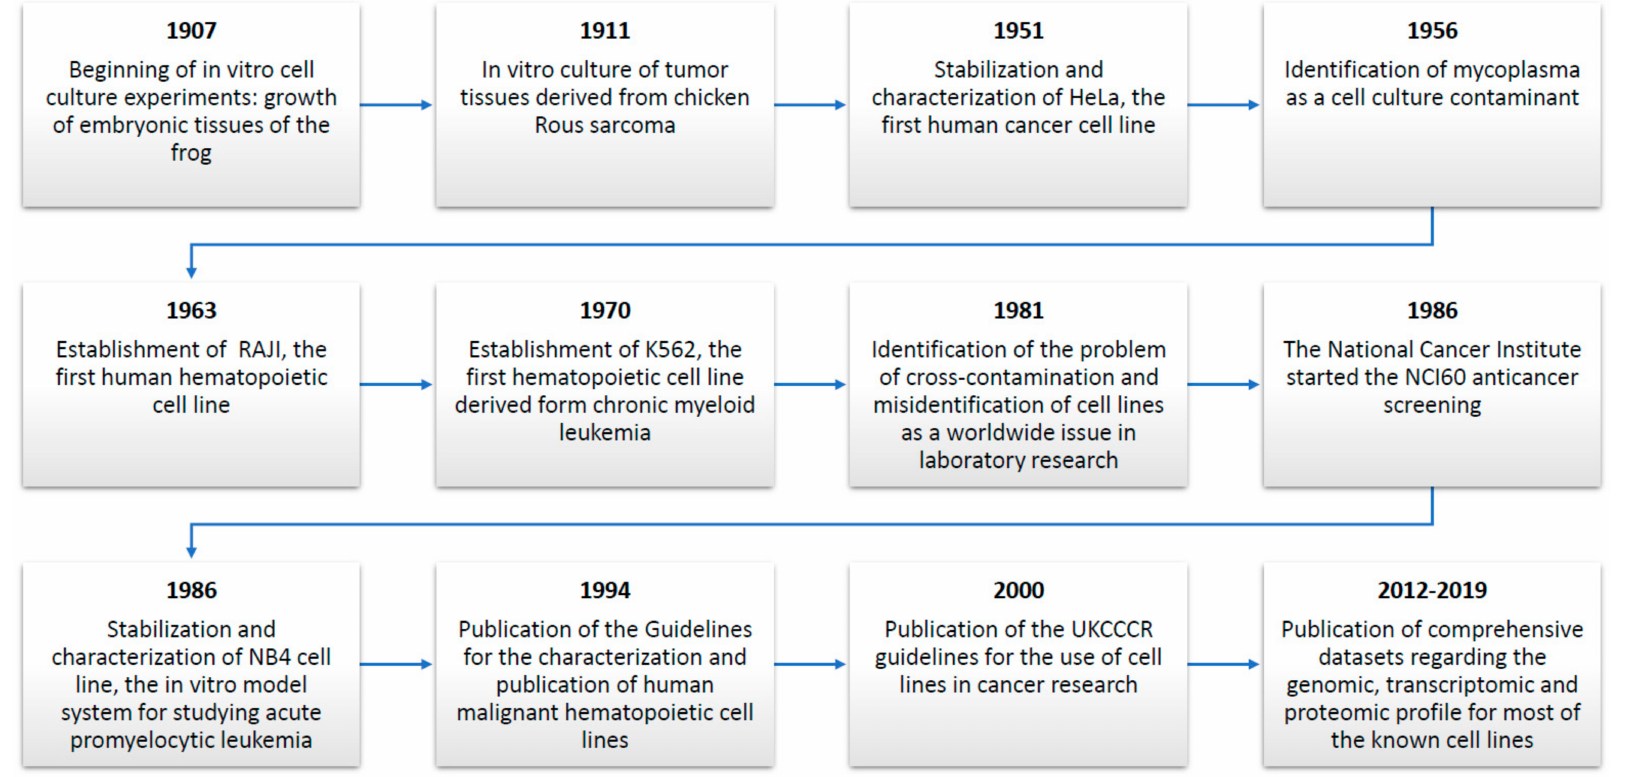
Figure 1. List of major breakthroughs in the historical progress of cancer cell